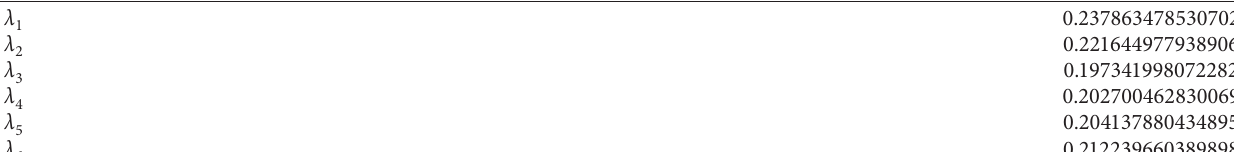
Table 7: The parameters of the DBGM (1, N ) model in case 3.